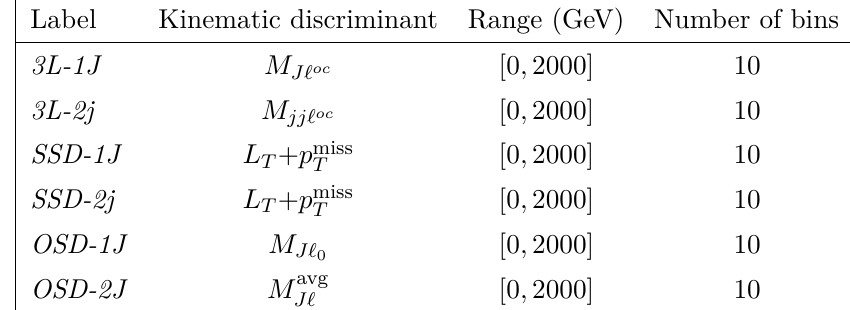
. The events are 1